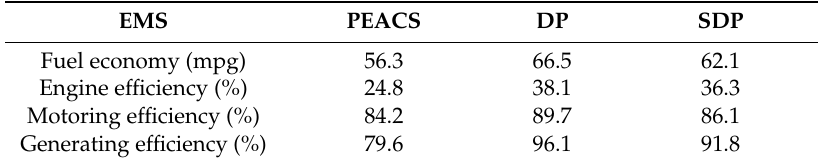
Table 5. Simulation results for 1015 + UDDS +